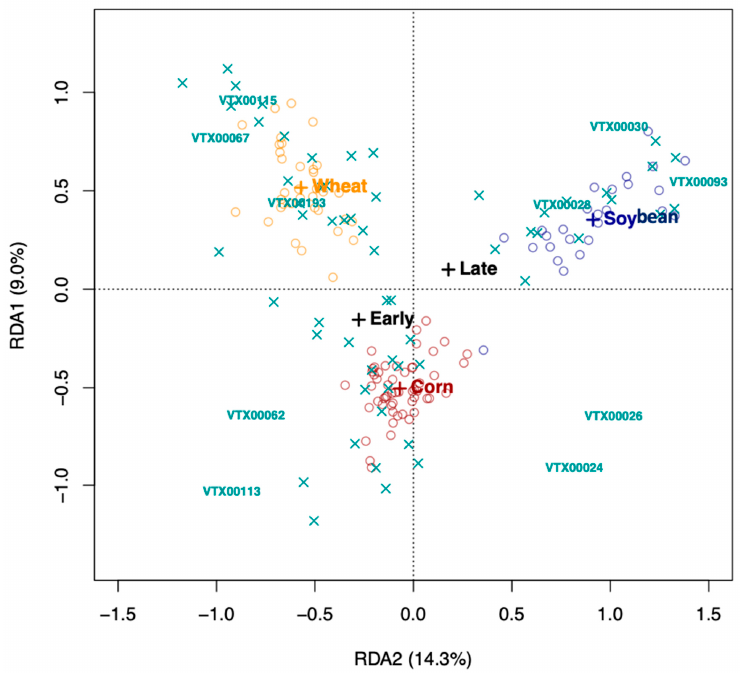
Figure 6. Redundancy analysis (RDA). Note that only the ten most abundant virtual taxa (VT, “X” signs) are labeled, “O” represents samples, and “+” represents centroids of the crop species (wheat, corn, and soybean) and growth stage (early vs. late). The inoculation treatments are not highlighted, as samples did not group accordingly (see Figure 5). The percentage of variance explained is indicated in brackets after the axis labels.